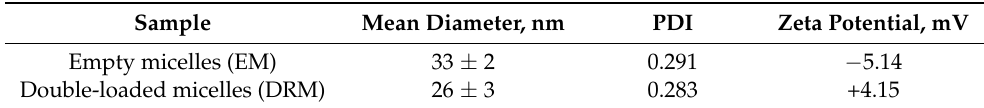
Table 1. Mean diameter, polydispersity index (PDI) and zeta potential of empty and double-loaded